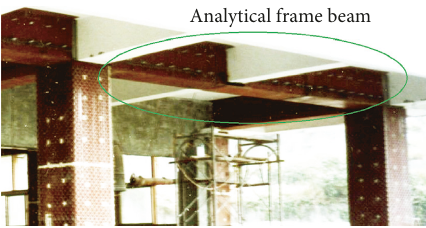
Figure 3: Picture of the RC frame beam strengthened by using the exterior-wrapping U-shaped steel